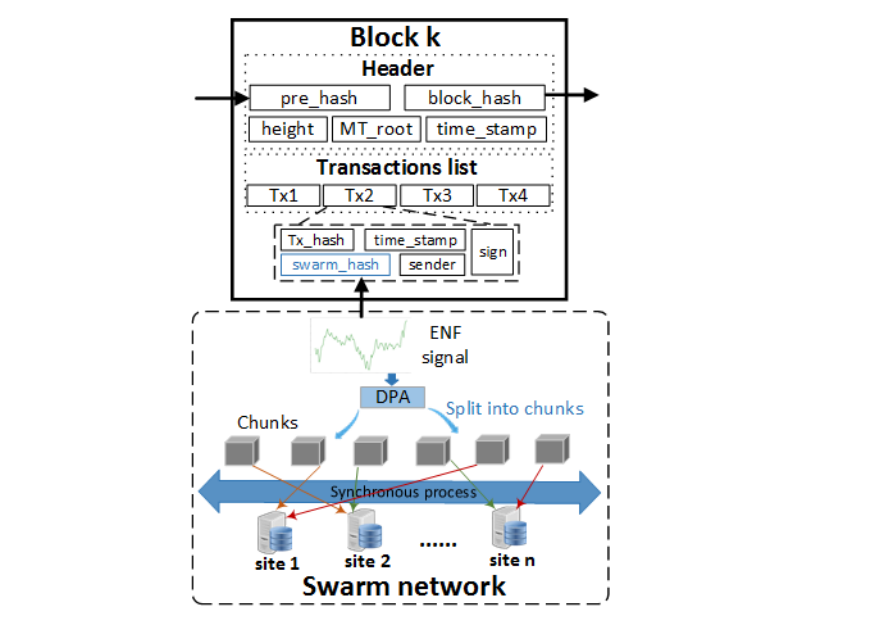
Figure 2. The illustration of block and off-chain data structure.